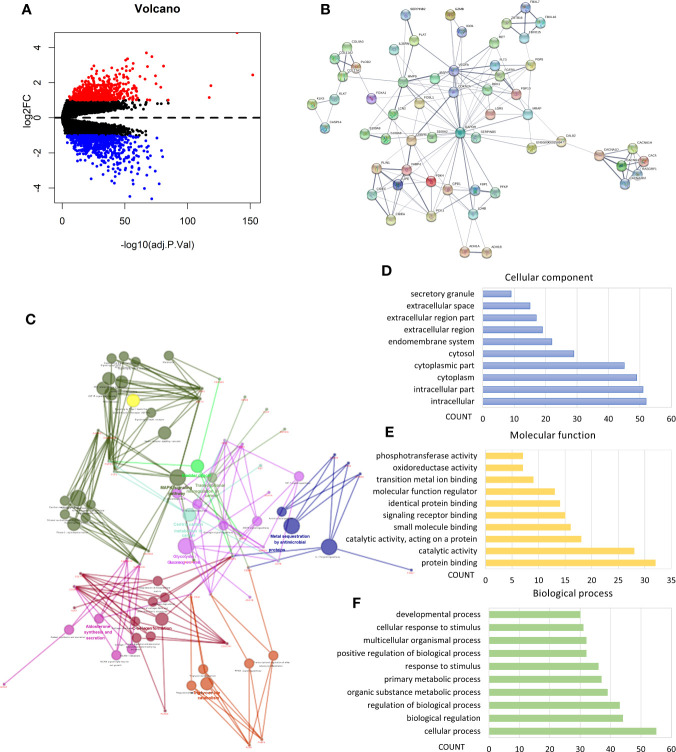
Identification of differentially expressed genes (DEGs) and Enrichment analysis. (A) Volcano plot for DEGs in cluster1 and cluster2. Red and blue dots represent up-regulated and down-regulated DEGs in cluster1 relative to cluster2, respectively (P < 0.05, |logFC| >1). (B) PPI network of a crucial sub-network with 58 nodes and 160 edges among DEGs. (C) Pathway enrichment analysis of the DEGs in the sub-network. (D–F) The top 10 items of GO analysis: biological processes, molecular functions and cellular components of the DEGs in the sub-network.